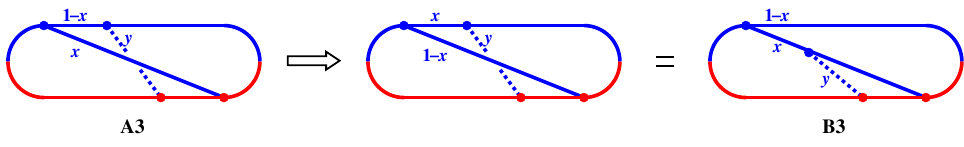
Figure 17 . Obtaining the B3 diagram from the A3 diagram by x → 1 − x